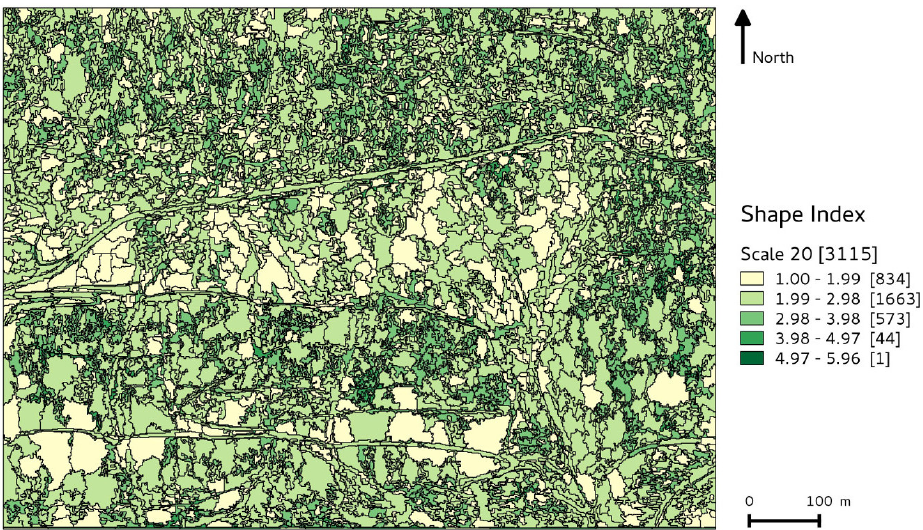
Figure 9. Median of the object shape index; segmentation with Baatz and Schäpe algorithm, at scale 70, providing 3115 objects; a classification with same class amplitude is used, with the [number of individuals per